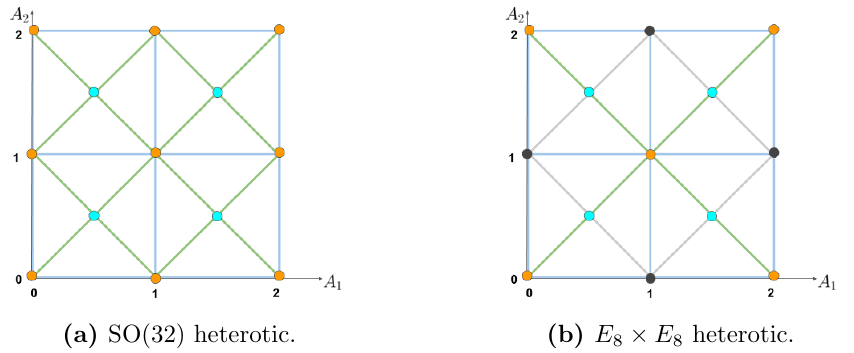
Figure 1. Enhancement groups on the left sector of the heterotic theory on the slice of moduli space de(cid:12)ned by A 3 ;:::; 16 = 0, R = R 0 with a generic R 0 > 1. See table 3 for